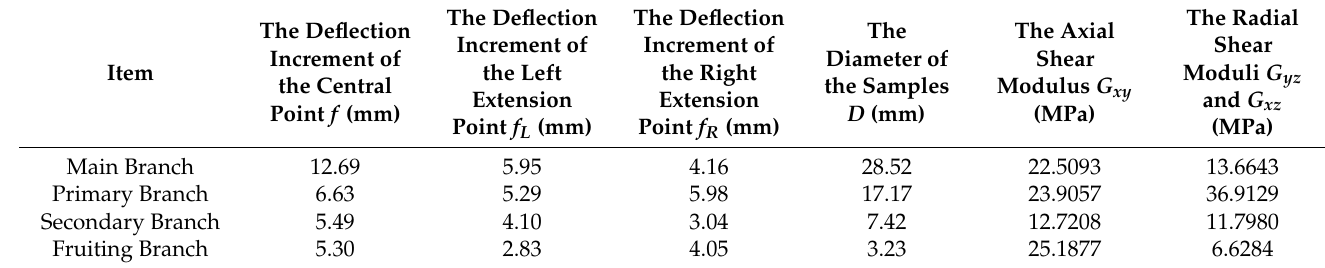
Table A3. The parameters of the branches in the shear